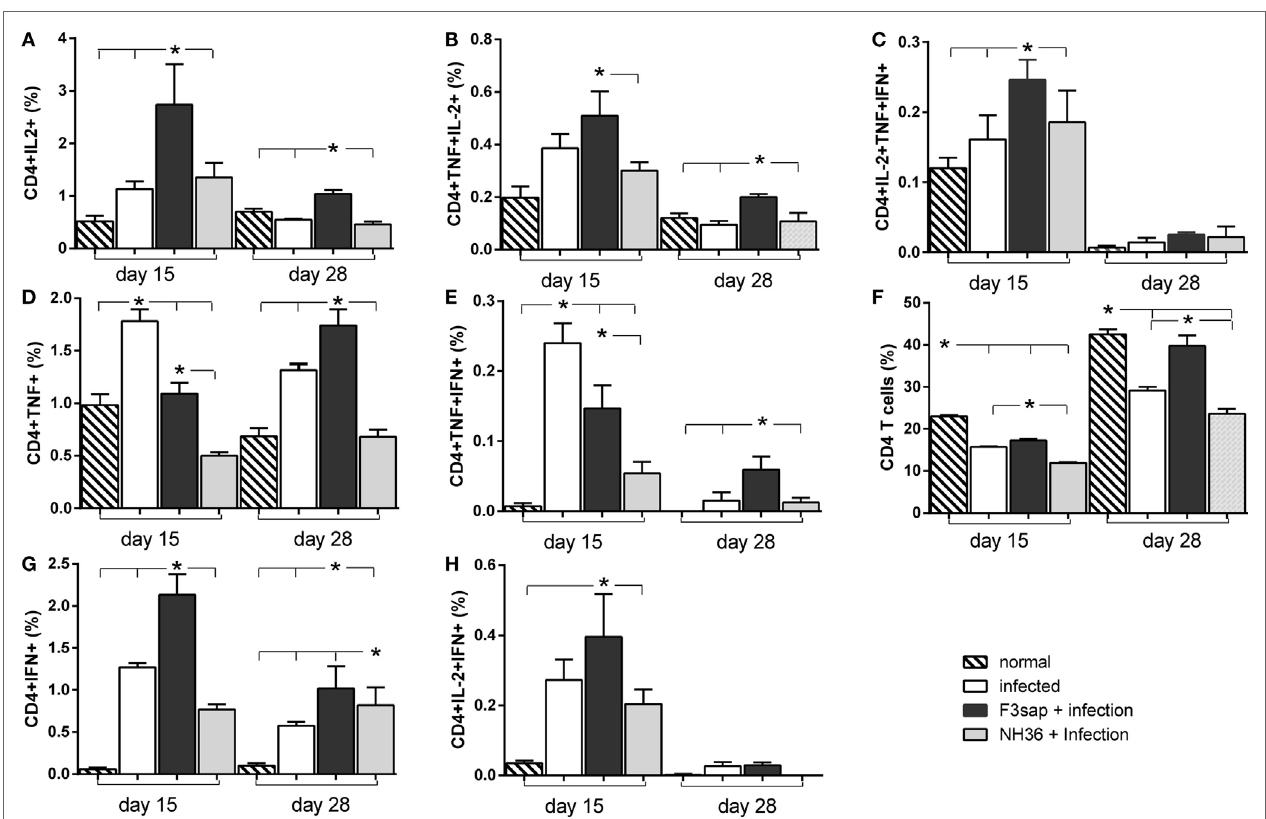
FigUre 9 | Cytokines expressed by CD4 + T lymphocytes in response to NH36. Effect of the F3 and NH36-vaccines on the frequencies of CD4 + IL-2 + (a) , TNF- α + (D) , IFN- γ + (g) , TNF- α + IL-2 + (B) , TNF- α + IFN- γ + (e) , IL-2 + IFN- γ + (h) , and IL-2 + TNF- α + IFN- γ + -secreting T cells (c) in response to the NH36 antigen, on day 15 and 28 post challenge. The total CD4 + T cell frequencies are also represented (F) . Bars represent the mean + SE values of two-independent experiments ( n = 5 mice per treatment in each experiment). Asterisks and horizontal lines show significant differences between treatments as disclosed by Mann–Whitney non-parametrical